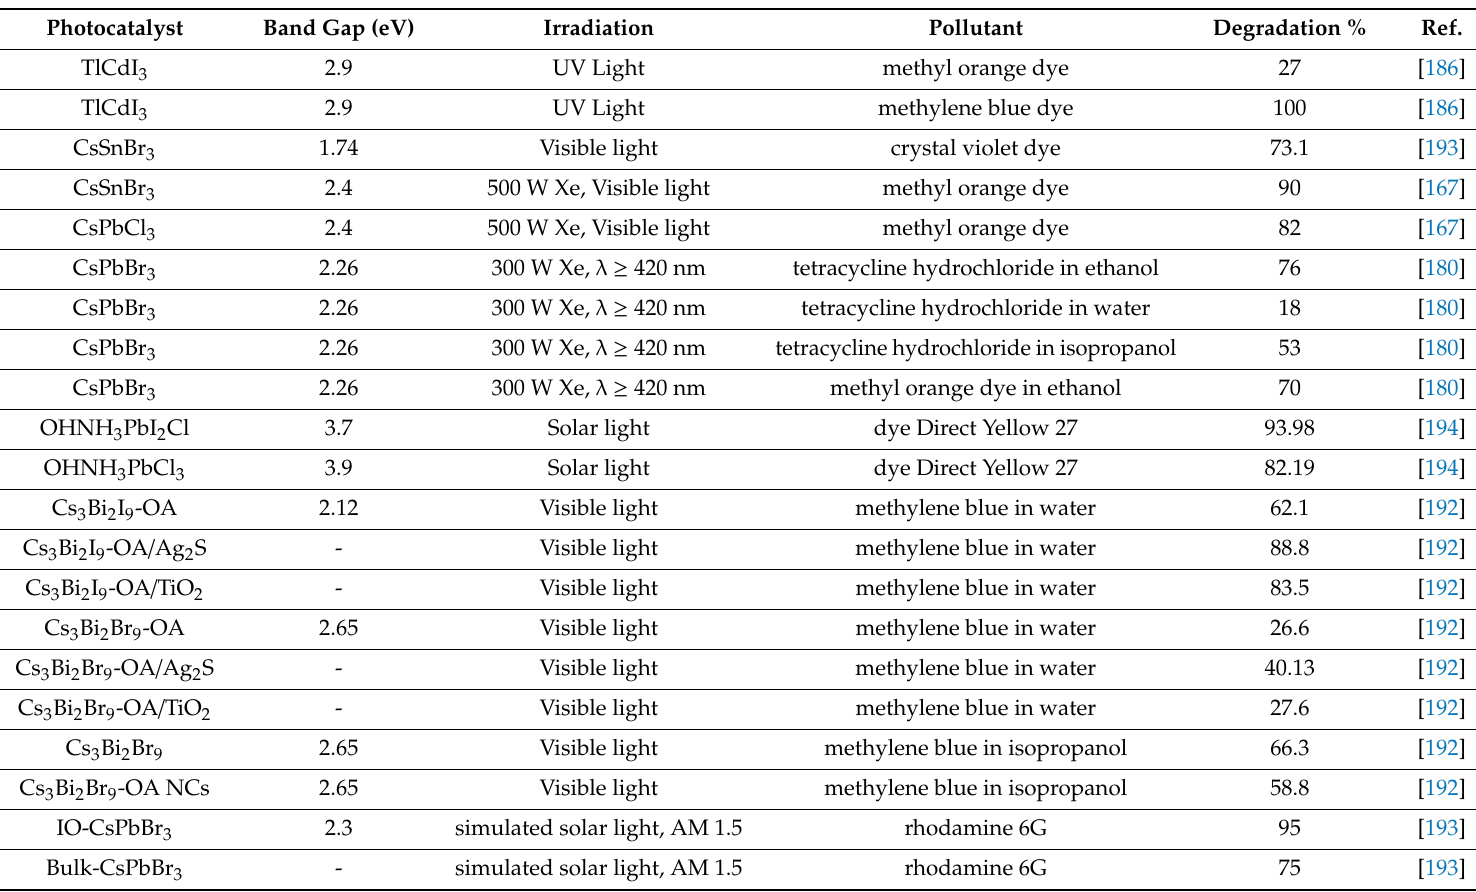
Table 4. Comparison of organic contaminants degradation percentage for di ff erent metal halide perovskites and their composites, reported in the